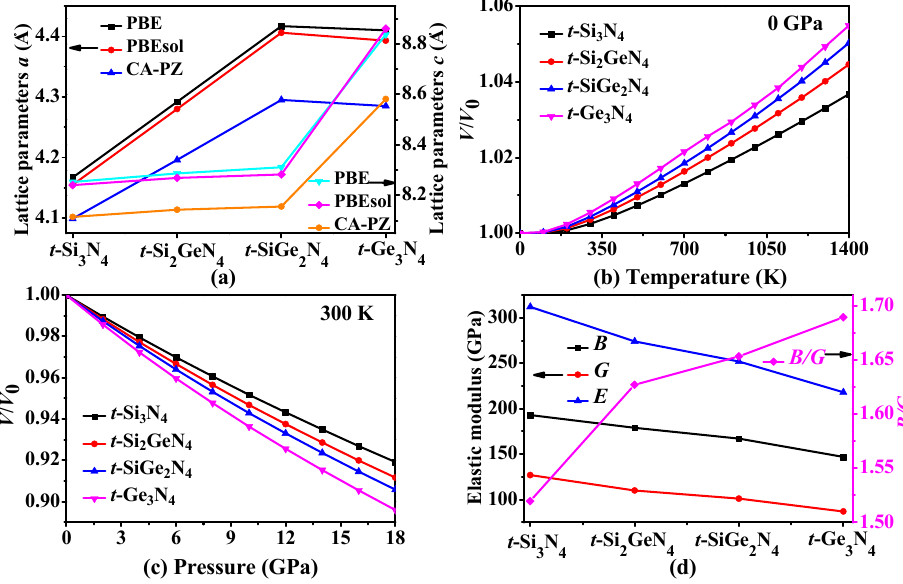
Figure 2. Calculated lattice parameters a and c ( a ) of t -Si 3 N 4 , t -Si 2 GeN 4 , t -SiGe 2 N 4 , and t -Ge 3 N 4 by PBE, PBEsol, and CA–PZ methods; the volume V / V 0 compression as functions of temperature ( b ) and pressure ( c ); the elastic moduli for t -Si 3 N 4 , t -Si 2 GeN 4 , t -SiGe 2 N 4 , and t -Ge 3 N 4 ( d ).